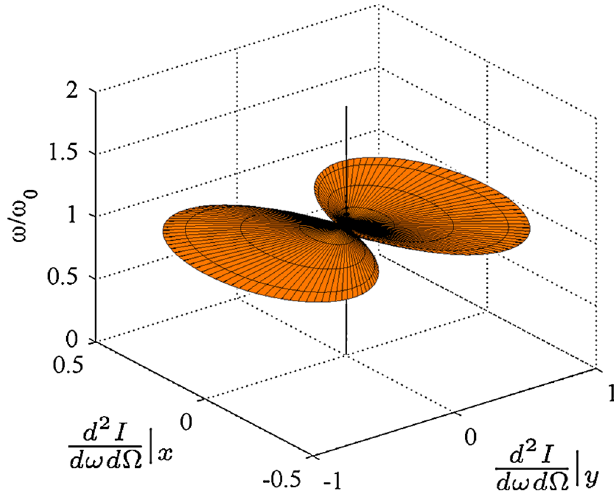
FIG. 4. (Color) Polar plot of radiation emitted by an electron oscillating in a linearly polarized plane electromagnetic wave, with low electric field strength (having a normalized vector potential of a 0 ¼ 0 : 01 ) with the field vector along the x axis, calculated numerically. The vertical axis is the frequency nor- malized to the laser frequency, and the horizontal plane gives the radiated intensity. The angular shape of the structure is a set of sin 2 (cid:3) lobes, in agreement with the analytic